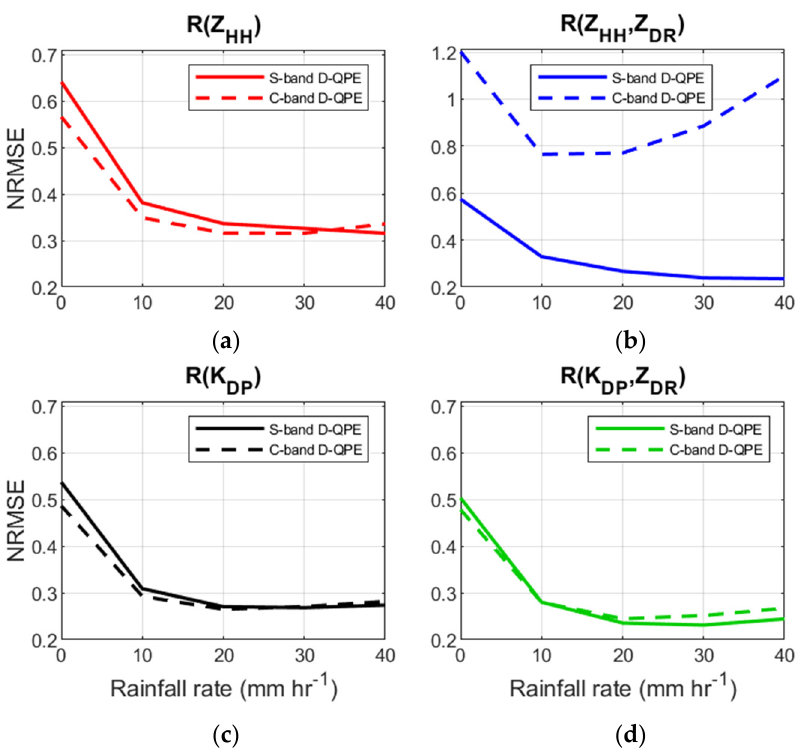
Figure 9. The NRMSE (as a function of rainfall rates) of C-/S-band D-QPEs from the ( a ) R(Z HH ), ( b ) R (Z HH , Z DR ) ( c ) R(K DP ), and ( d ) R (K DP , Z DR ) algorithm.